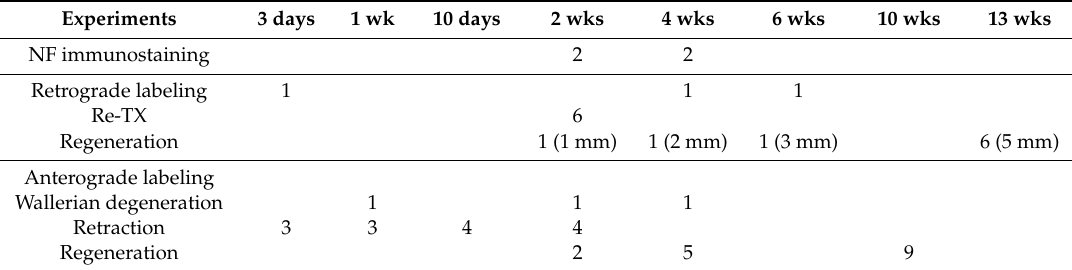
Table 1. Numbers of animals used for each experiment. Wks are weeks after spinal cord transection (TX). The distance of DTMR application caudal to the original TX site is given in parentheses.